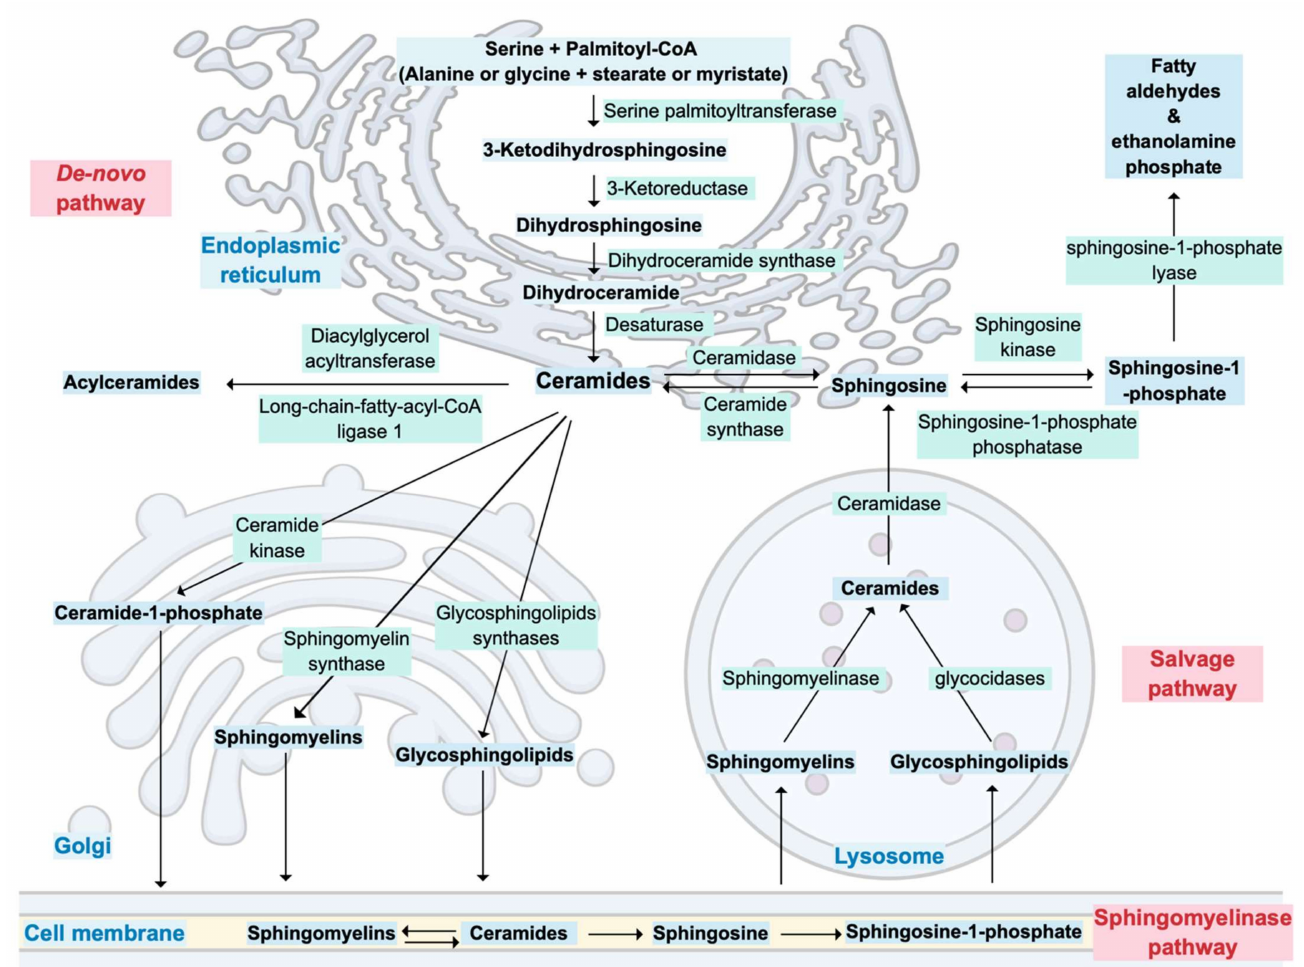
Figure 1. Overview of ceramide metabolism and its cellular